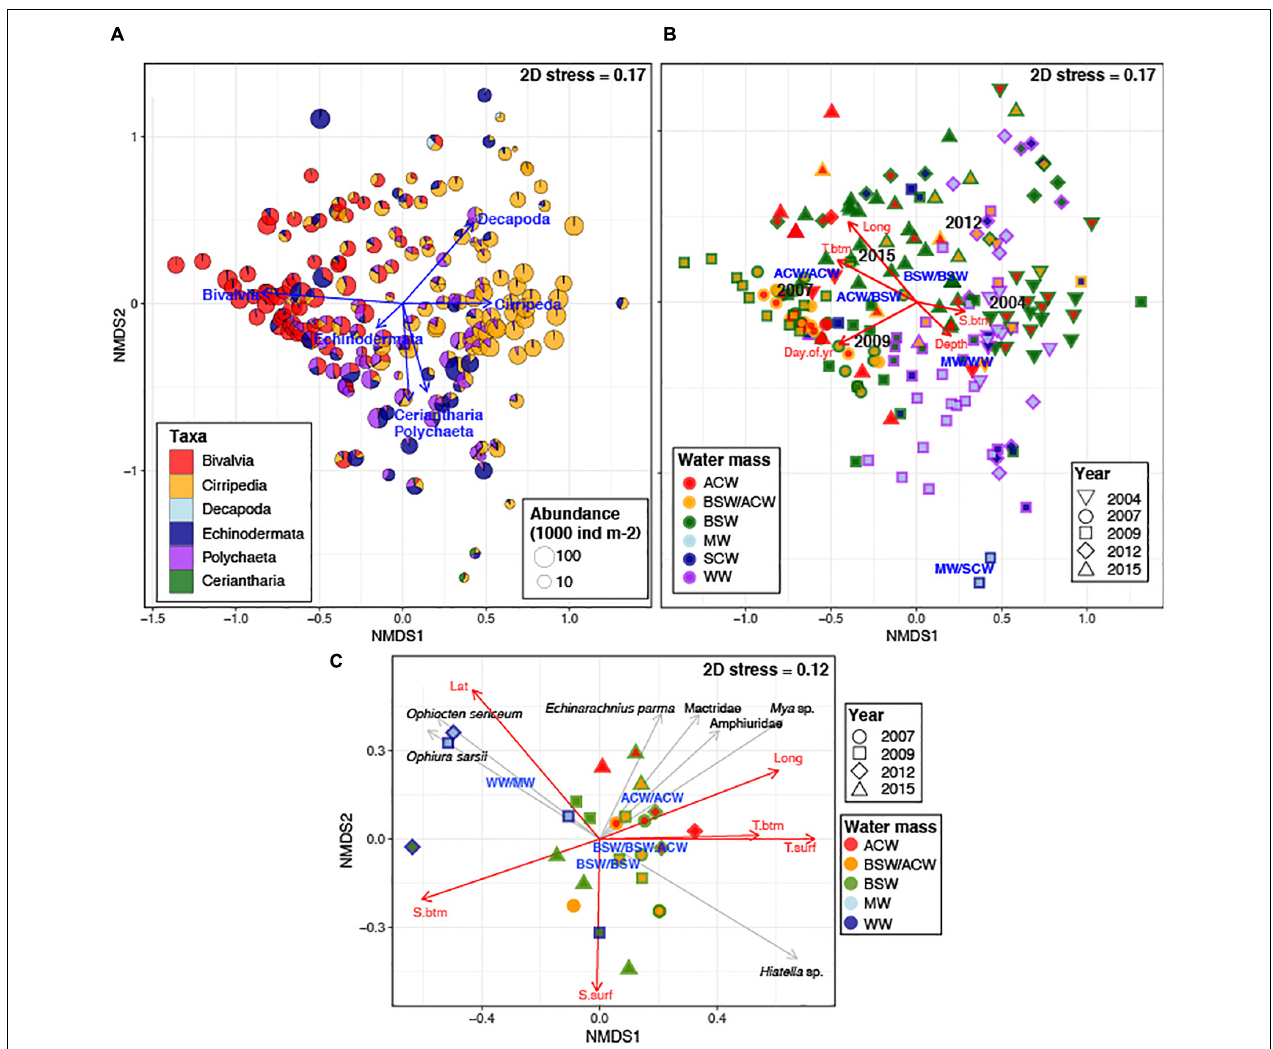
FIGURE 10 | nMDS ordination of log-transformed abundance of meroplankton groups with (A) relative contribution of taxa at each station; and (B) water mass types at each station (symbols represent year sampled; outer color represents bottom water mass; inner color – surface water); (C) nMDS ordination of log-transformed abundance of bivalve and echinoderm species at stations where barcoding was done; symbols represent year sampled; outer color represents bottom water mass; inner color – surface water; On all plots, vectors indicate significant ( p < 0.05) correlations of taxa abundances (gray arrows)/physical parameters (red arrows) to the ordination, with length reflecting R 2 , and text labels the centroids for each respective Year and Water Mass. T.btm, bottom temperature; S.btm, bottom salinity; T. surf, surface temperature; S.surf, surface salinity; Lat, latitude; Long, longitude; Day.of.yr, day of year sampled; Depth, bottom depth. Water masses are listed as Bottom Water Mass/Surface Water mass: BSAW, Bering Sea Anadyr Water; ACW, Alaska Coastal Water; BSAW.ACW, Bering Sea Anadyr/Alaska Coastal Water (mix or uncertain); WW, Winter water; SCW, Siberian Coastal